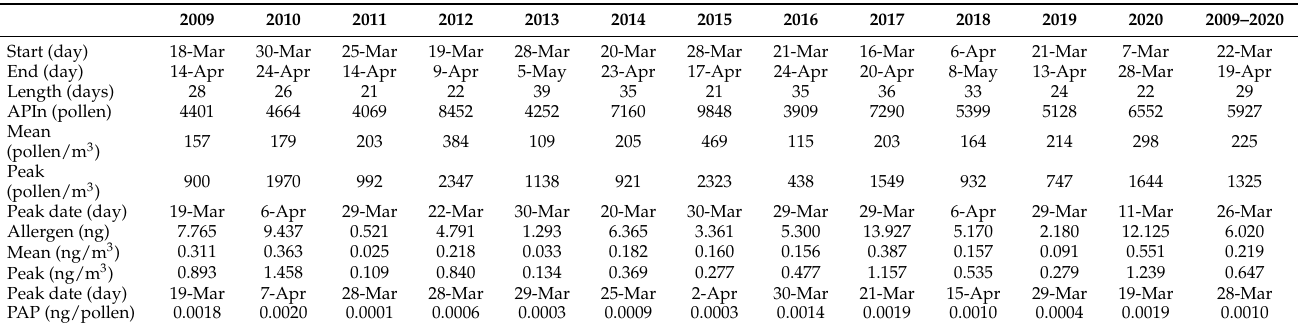
Table 1. Start and end date and length (days) of the main pollen season (MPS), annual pollen integral (APIn) during the MPS (pollen), mean of pollen (pollen/m 3 ), pollen peak (pollen/m 3 ), and pollen peak day (day), allergen concentration during MPS (ng), mean of allergen (ng/m 3 ), allergen peak (ng/m 3 ), allergen peak day (day) and pollen allergen potency (PAP)